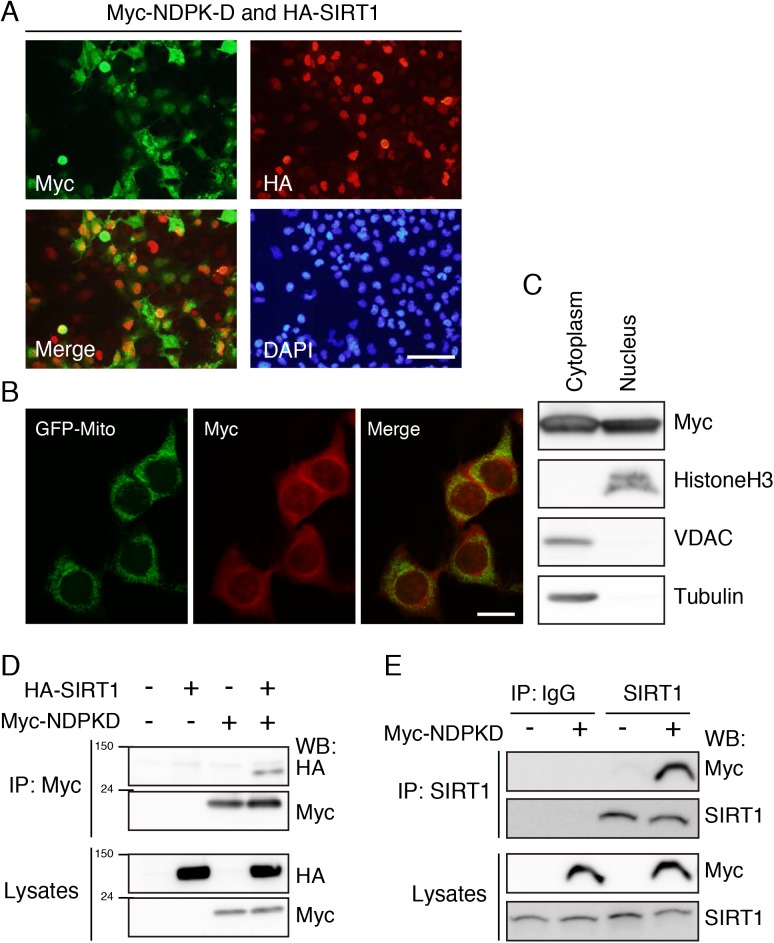
SIRT1 interacts with NDPK-D.(A) Localization of SIRT1 and NDPK-D. COS-7 cells transfected with plasmids encoding HA-SIRT1 and Myc-NDPK-D were cultured for 36 h, and immunostained with anti-HA and anti-Myc antibodies. Scale bar: 100 μm. (B) Cytosolic NDPK-D partially co-localized with mitochondria-targeted GFP. Cells transfected with plasmids encoding Myc-NDPK-D and mitochondria-targeted GFP were immunostained with anti-Myc and anti-GFP antibodies. Scale bar: 20 μm. (C) NDPK-D localized to both cytoplasmic and nuclear fractions. COS-7 cells were transfected with Myc-NDPK-D, and cultured for 36 h. Cytoplasmic and nuclear fractions were isolated and subjected to western blotting using indicated antibodies. (D) Co-immunoprecipitation of SIRT1 and NDPK-D. Cells were transiently transfected with the indicated plasmids and lysates were immunoprecipitated with anti-Myc antibody. The immunoprecipitates were immunoblotted with anti-HA antibody. (E) Co-immunoprecipitation of Endogenous SIRT1 and Myc-tagged NDPK-D. Cells were immunoprecipitated with anti-SIRT1 or control IgG antibody. The immunoprecipitates were immunoblotted with anti-Myc antibody.